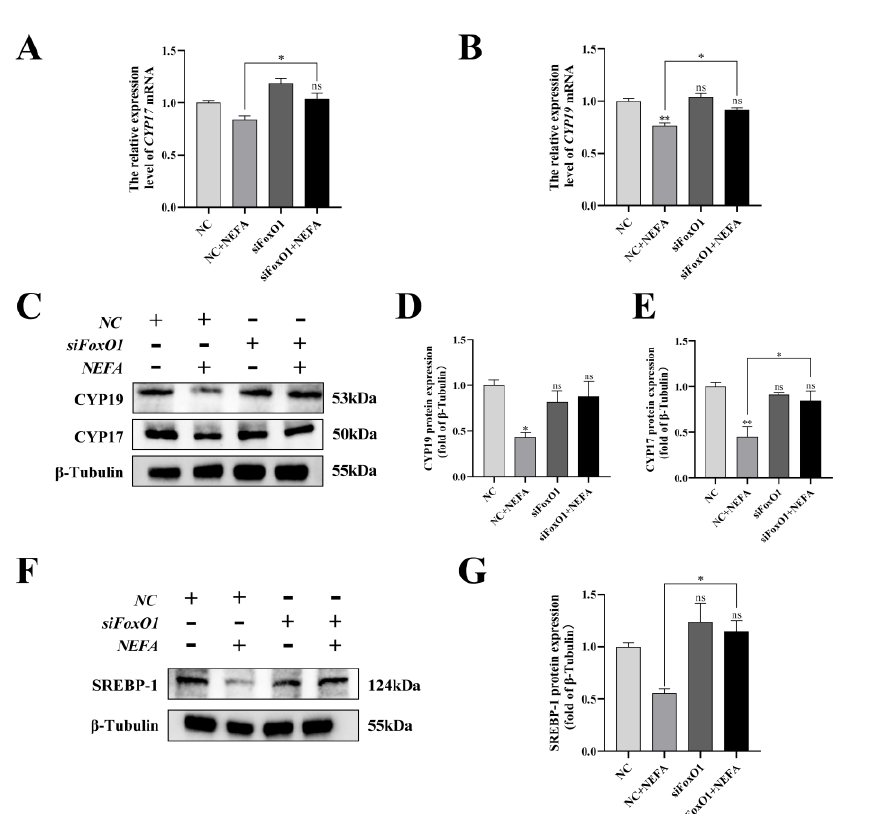
Figure 12. Effects of the si − FoxO1 on NEFA − induced steroid hormone synthesis gene expression in BGCs. BGCs were transfected with NC or siFoxO1 for 6 h before being treated with NEFA for 24 h. ( A – E ) CYP17 and CYP19 protein and gene expression in BGCs under treatment with siFoxO1/siNC. ( F , G ) SREBP − 1 protein expression in BGCs after the silence of FoxO1. The quantification of the relative protein levels (performed using Image J) is shown under the band (protein/ β − Tubulin). This experiment was repeated 3 times, and data are expressed as mean ± standard errors of the mean (SEM), * p < 0.05; ** p < 0.01; ns, not significant.